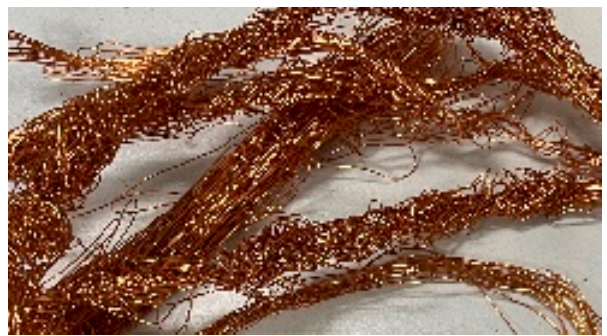
Figure 2. Copper wire inserted into the air tank.